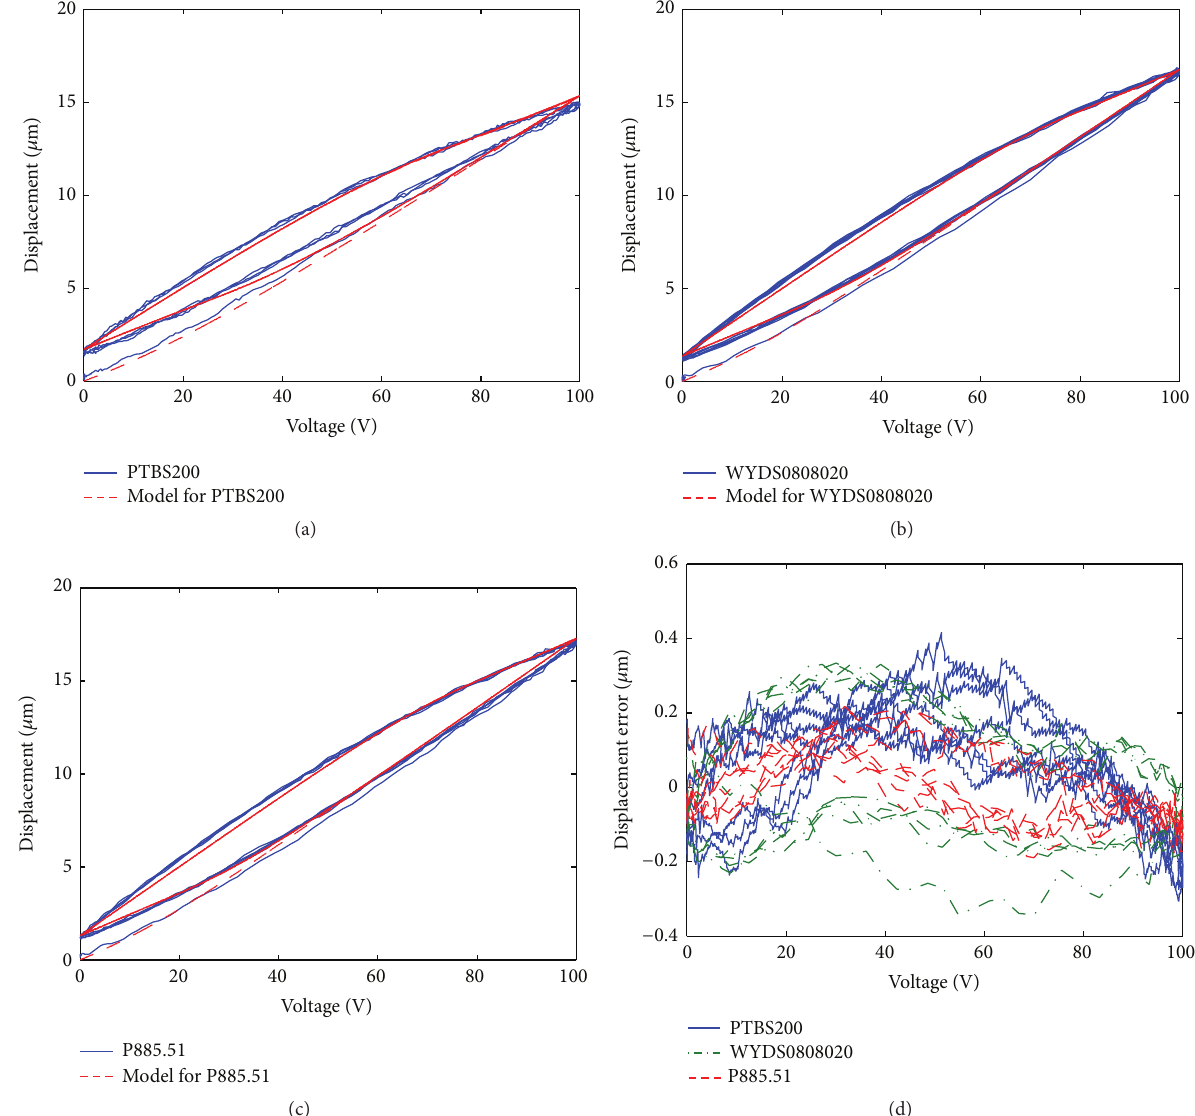
Figure 8: Hysteresis curves from the three PSAs measured by the LDV and predicted by the modified comprehensive model: (a) PTBS200, (b) WYDS0808020, (c) P885.51, and (d) the modeling